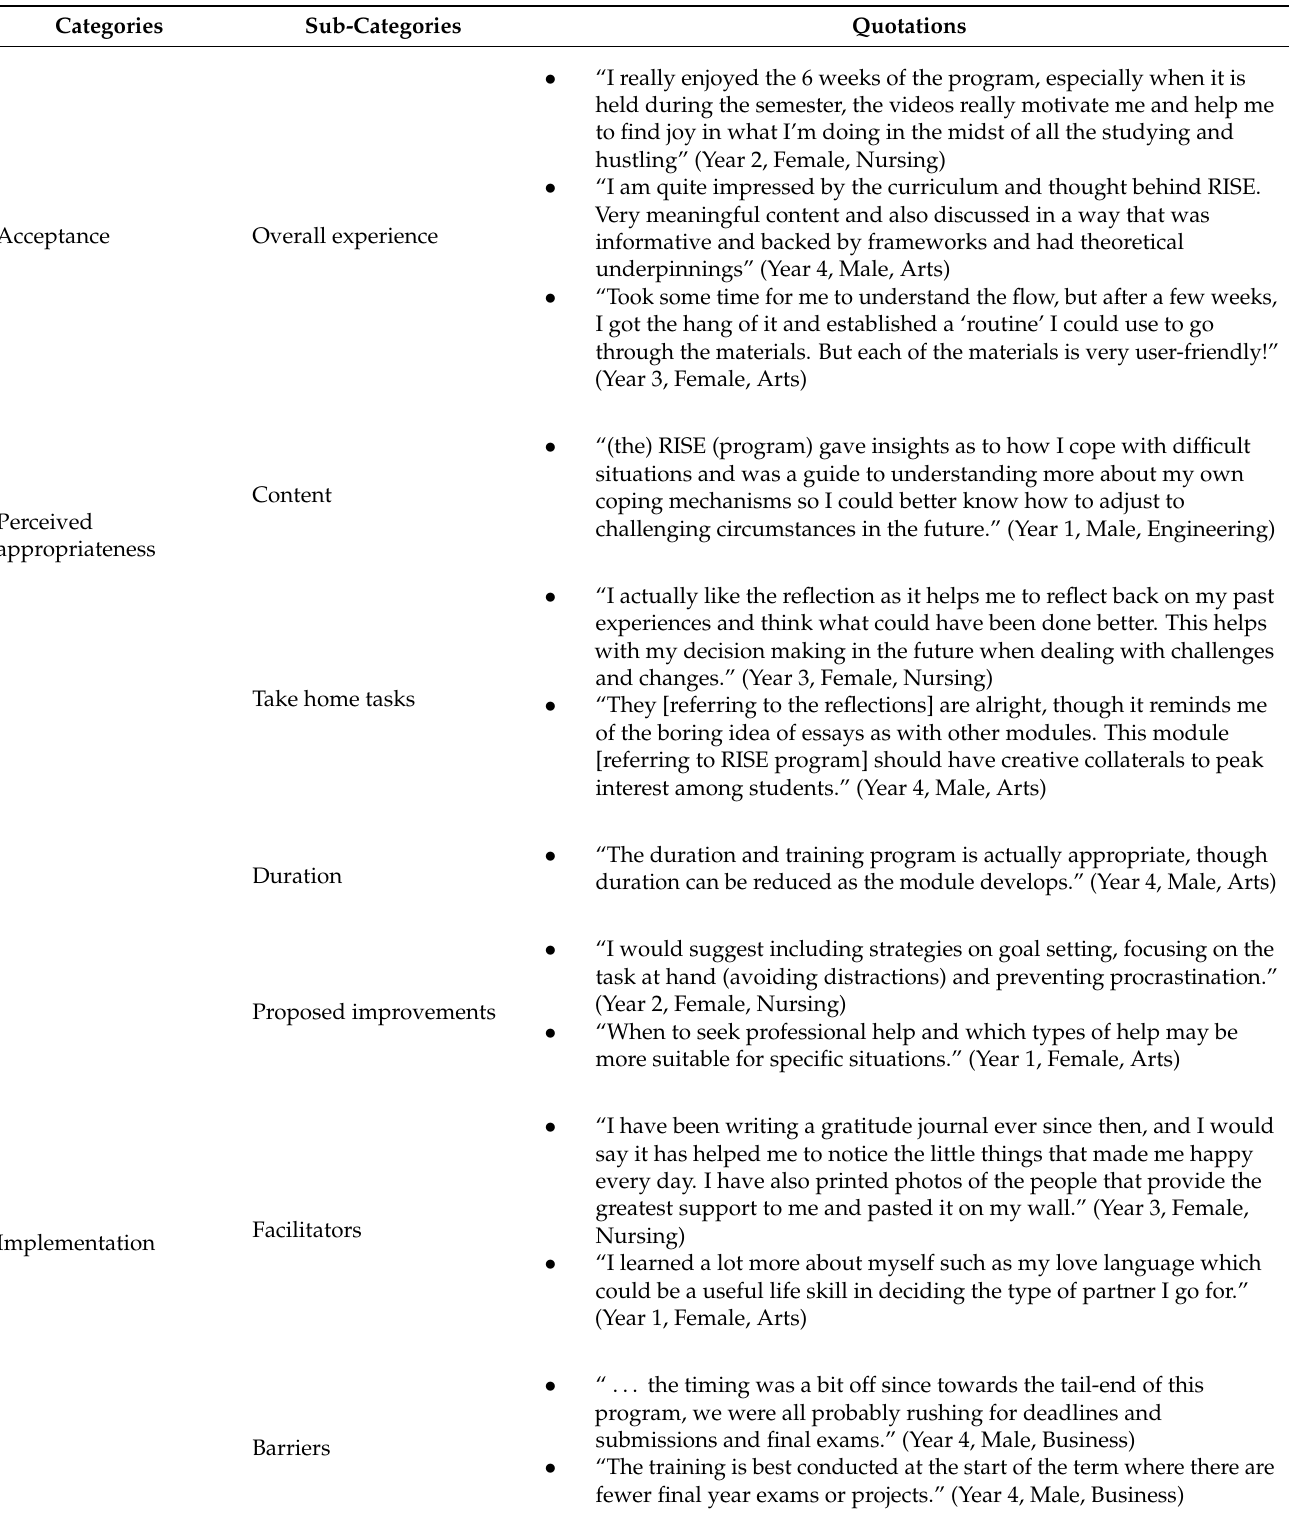
Table 3. Students’ acceptance, perceived appropriateness and demand, and actual use of the RISE